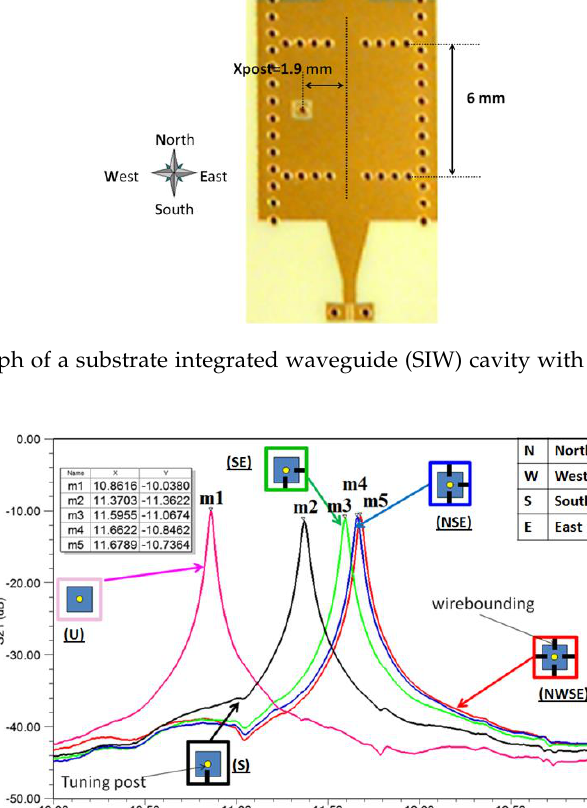
Figure 2. Measurement results for di ff erent connection states: (NWSE) four, (NSE) three, (SE) two, (S) Figure 2. Measurement results for different connection states: (NWSE) four, (NSE) three, (SE) two, (S) one and (U) no wire bondings. one and (U) no wire bondings. Table 1. Frequency shift as a function of switched Figure 2. Measurement results for different connection states: (NWSE) four, (NSE) three, (SE) two, (S) one and (U) no wire bondings.